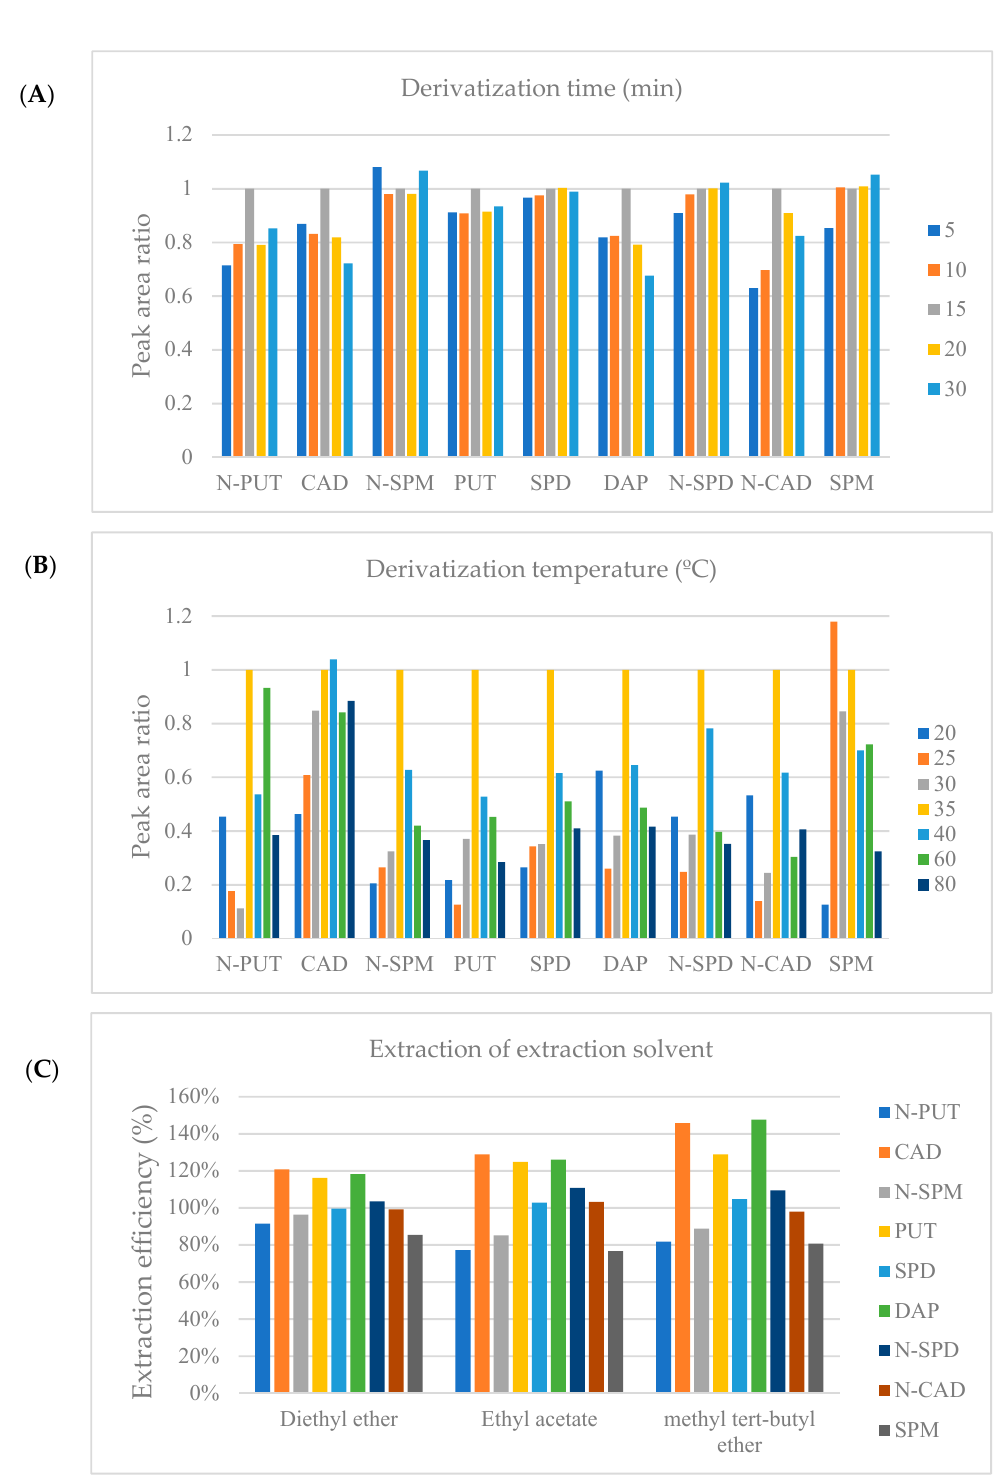
Figure 1. Comparison of the optimization procedures. ( A ) Isobutyl chloroformate derivatization under varying conditions including reaction time, ( B ) isobutyl chloroformate derivatization under varying reaction temperatures, and ( C ) extraction of liquid–liquid extraction solvents (N-PUT: N -acetyl putrescine; CAD: cadaverine; N-SPM: N -acetyl spermine; PUT: putrescine; SPD: spermidine; DAP: 1,3-diaminopropane; N-SPD: N -acetyl spermidine; N-CAD: N -acetyl cadaverine; SPM: spermine). The peak area ratios were expressed by dividing ( A ) 15 min and ( B ) 35 °C as standard values that we used for the conditions of this experiment.